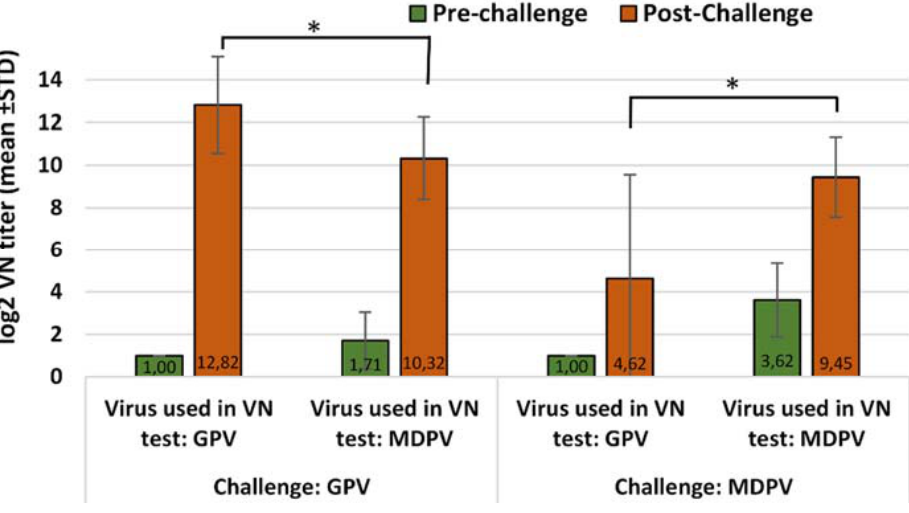
Figure 2. Humoral antibody response to GPV and MDPV in MDA-free ducks, vaccinated with monovalent MDPV vaccine then challenged with GPV or MDPV strains at 2 weeks of age. Statistical comparison of post ‐ challenge virus neutralization titers against GPV and MDPV indicate significant differences in the case of both GPV and MDPV challenge infections (* p = 0.0323 and * p = 0.0218 respectively).